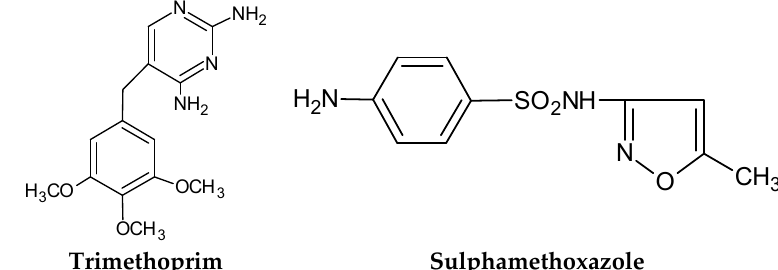
Figure 7. Structure of co-trimoxazole.